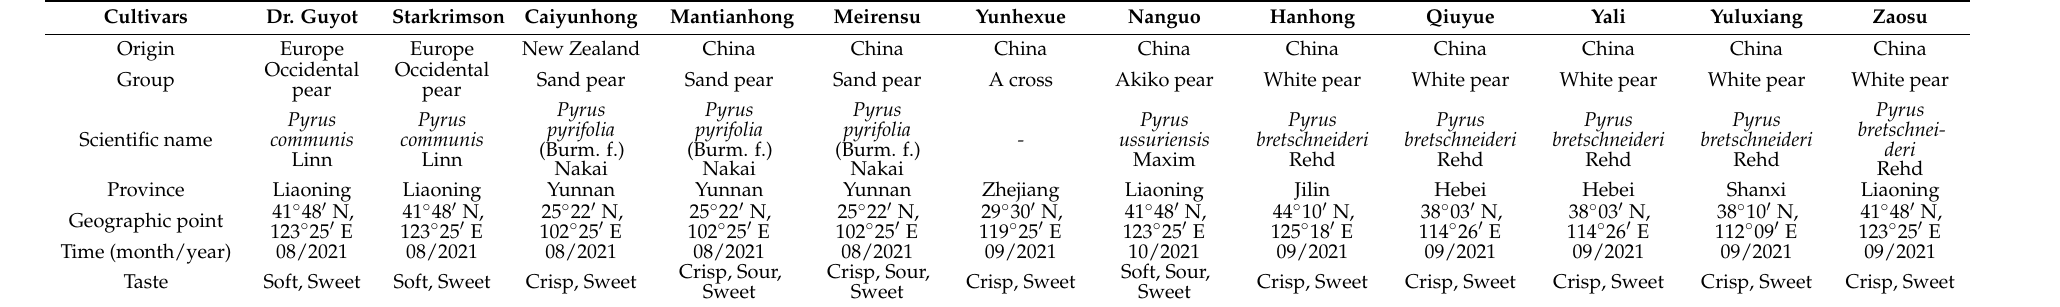
Table 1. The origin, group, scientific name, province, geographic point, sampling time, and characteristic taste of pear fruit of 12